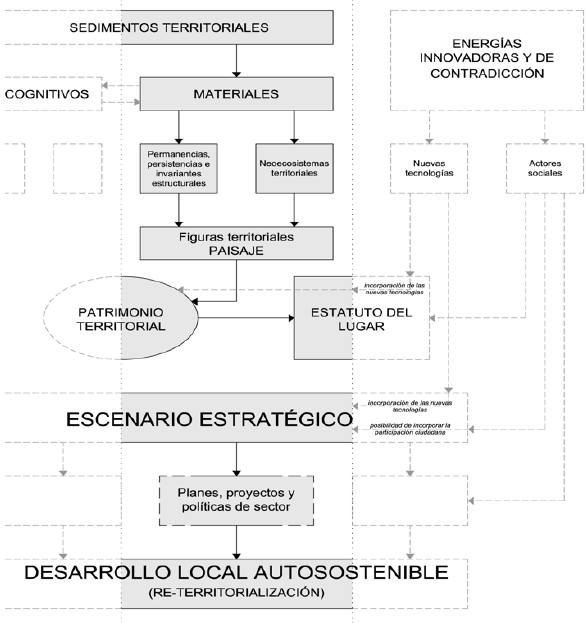
Figure 3. Towards a landscape architecture methodology in the framework of an integrated plan for territory. © Rebeca